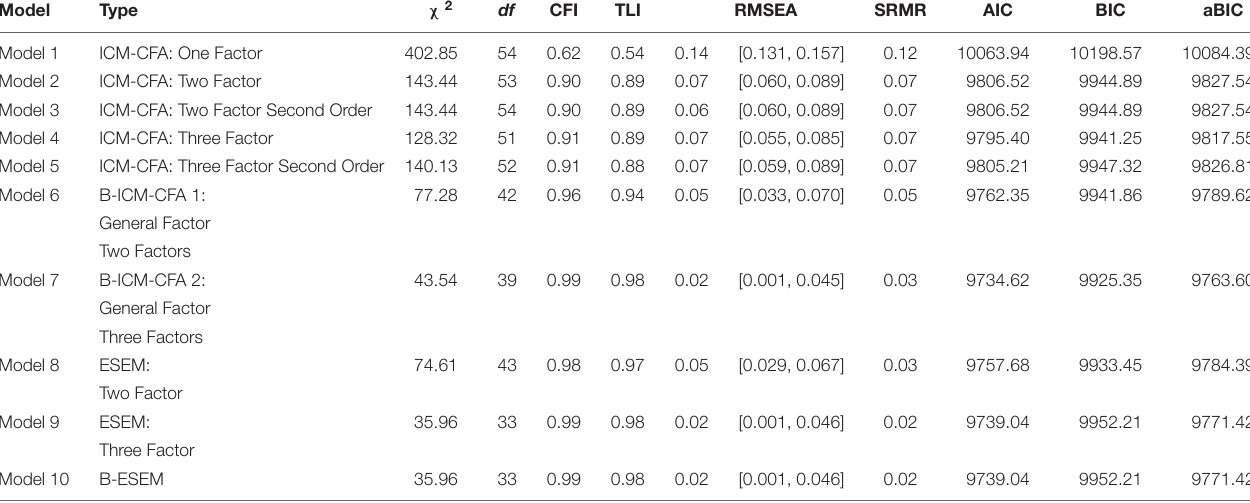
TABLE 3 | Goodness-of-fit statistics and information criteria for the competing measurement